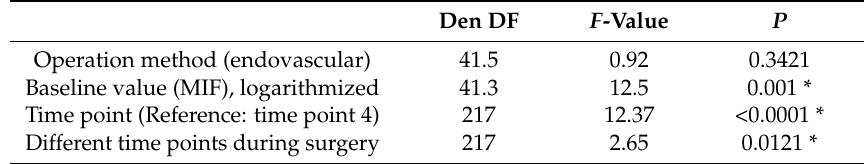
Table 3. Multivariate analysis of different factors with influence on the